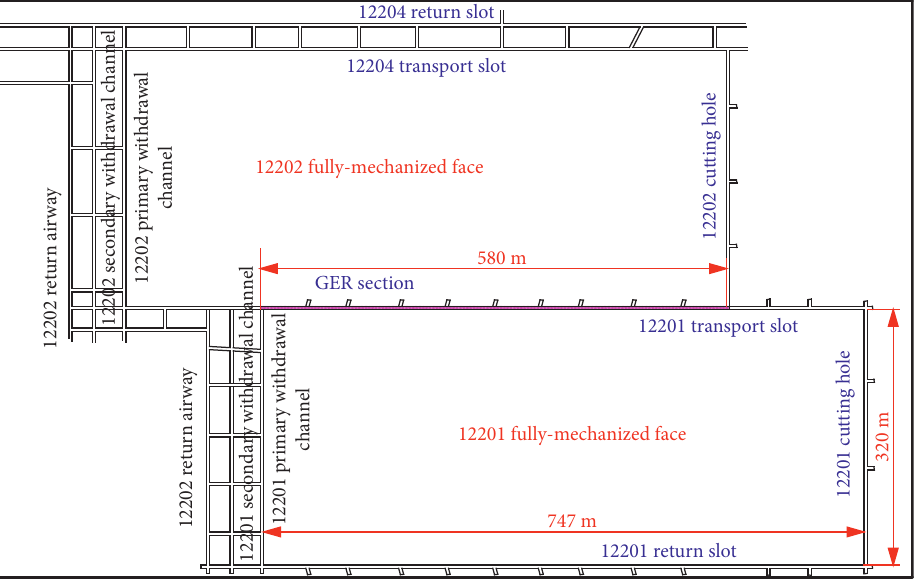
Figure 1: Diagram of the 12201 work surface layout.